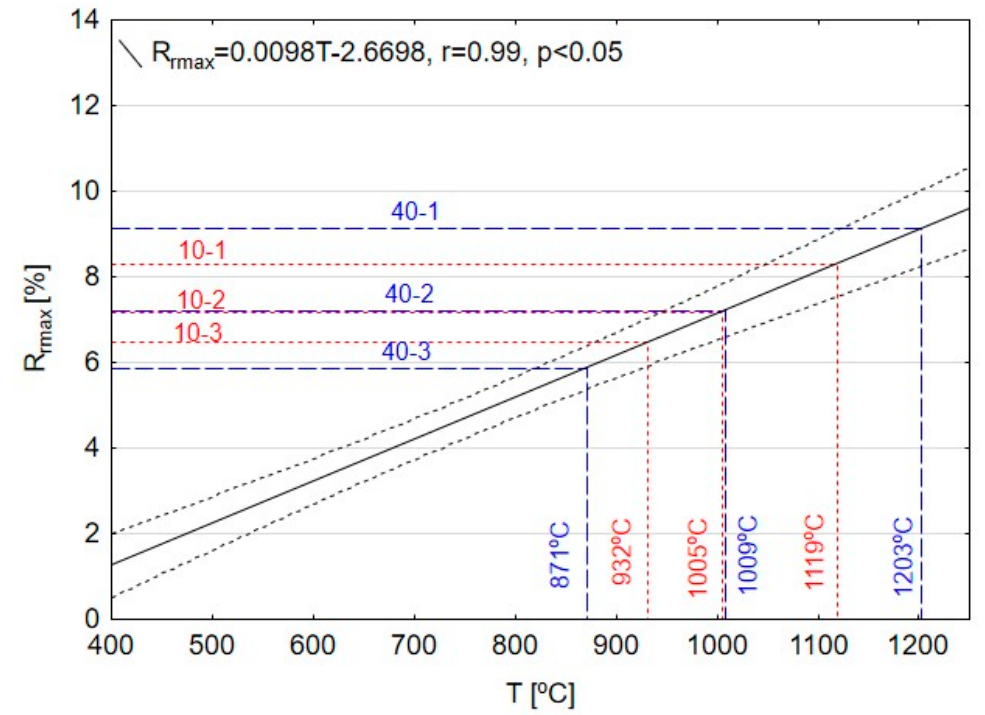
Figure 11. Comparison of maximum vitrinite reflectance with the data obtained for cokes produced in laboratory conditions [37,39].